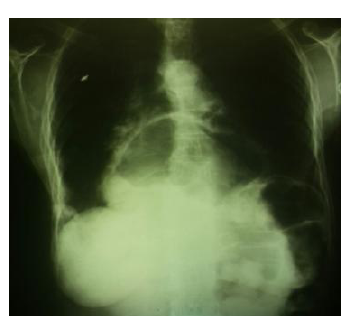
Figure 1. Chest X-ray of patient before surgery